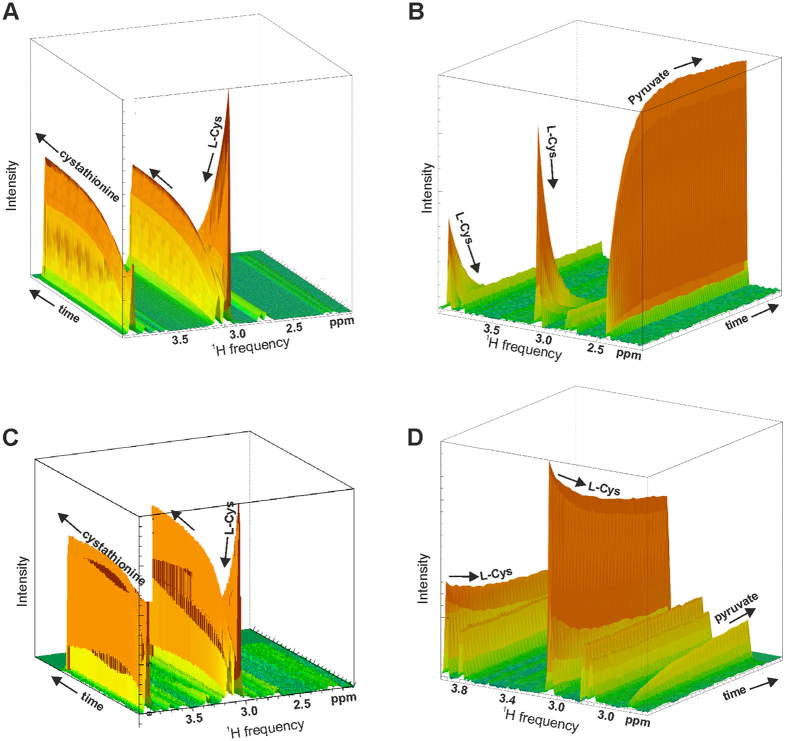
Enzymatic kinetics followed by metabolomics.Pseudo 3D plots of CBS and CSE enzymatic kinetics. The data are presented as pseudo 3D plots where the first increment of 13C HSQC spectra is plotted along the x (F2) and y axes. Time is plotted on the third axis. The first spectrum was obtained ~2 min after the addition of the enzyme, and subsequently 59 spectra were collected over a 300 min period. Kinetics of control isolated CBS (A) and CSE (B). Time course of CBS (C) and CSE (D) in the presence of compound 2a (250 μM). Disappearance of the resonance at 3 ppm testifies conversion of L-cysteine to L-cystathionine by CBS and to pyruvate by CSE. The spectra were recorded at 800 MHz and 37 °C using L-Cys concentrations of 250 μM. Enzyme concentrations of 20 μM.